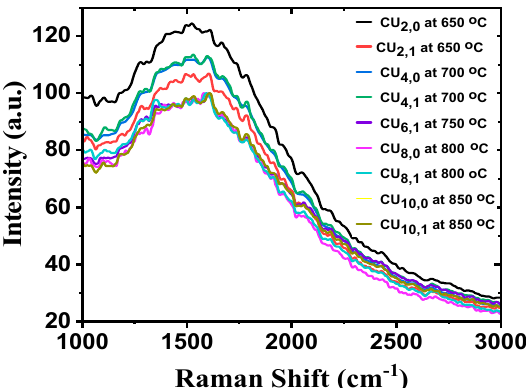
Figure 3. Raman spectra at a constant CH 4 flow rate at 10 sccm and different deposition